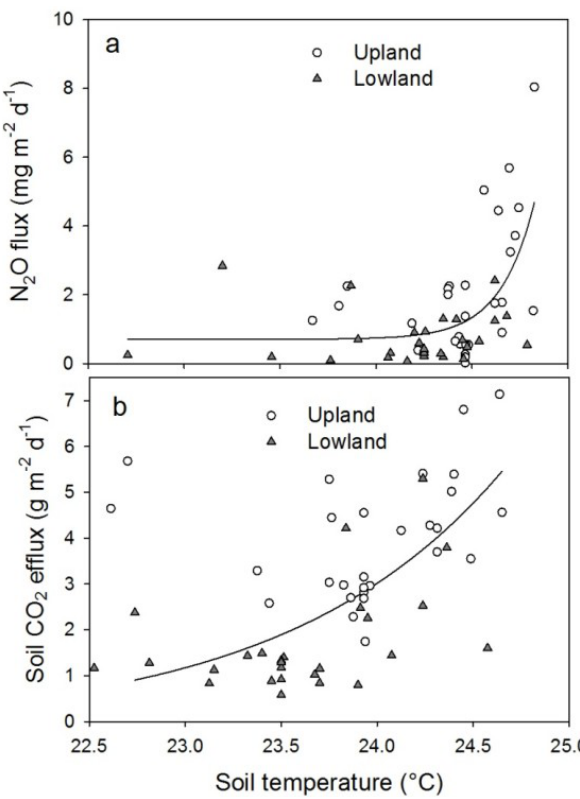
Fig. 5. N 2 O and CO 2 daily average fluxes plotted versus soil tem- perature. The regression lines are exponential fit of both uphill and downhill data sets. N 2 O (a) R 2 = 0 . 35, P< 0 . 0001, DF = 57 and CO 2 (b) R 2 = 0 . 46, P< 0 . 0001, DF =